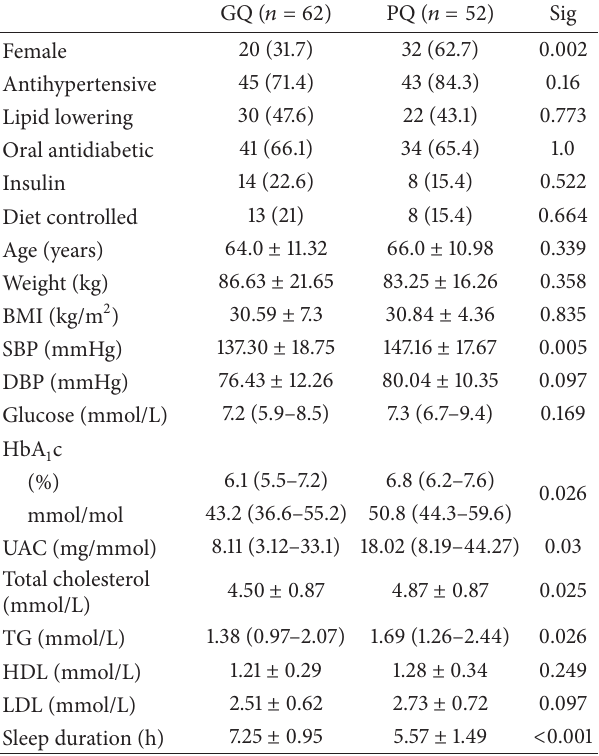
Table 1: Baseline characteristics based on sleep